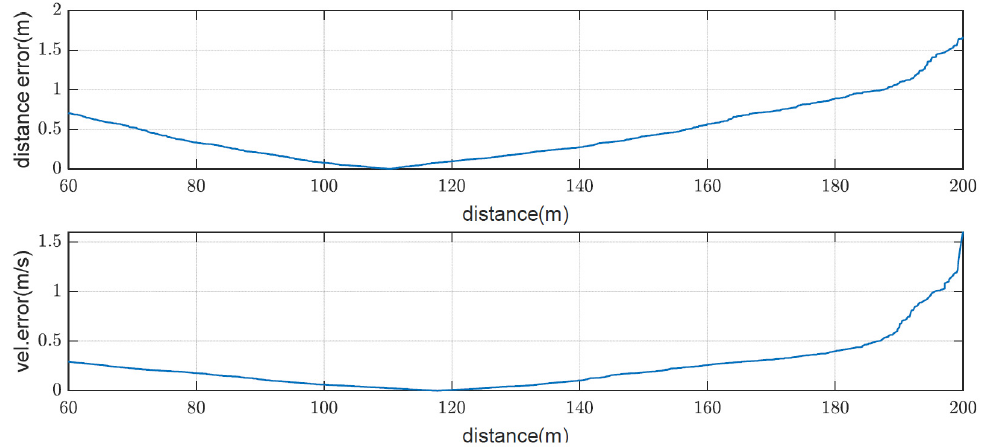
Figure 20. Distance and velocity errors according to the distance. To test the range resolution, two corner reflectors were set up, as shown in Figure 21. The plan position indication (PPI) in Figure 22 displays the resolved targets 40 cm apart. Although the ideal resolution was 10 cm, the reliable resolution in the experiment was approximately 40 cm. This might be caused by hardware and processing restrictions. Other green lines are the objects on the site.